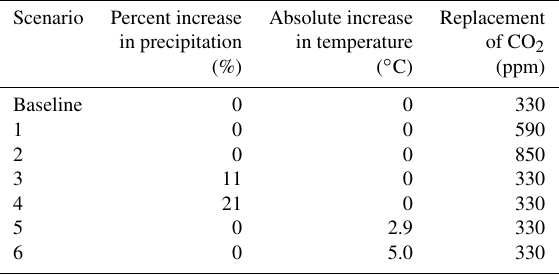
Table 4. Climate sensitivity scenarios developed by modifying baseline